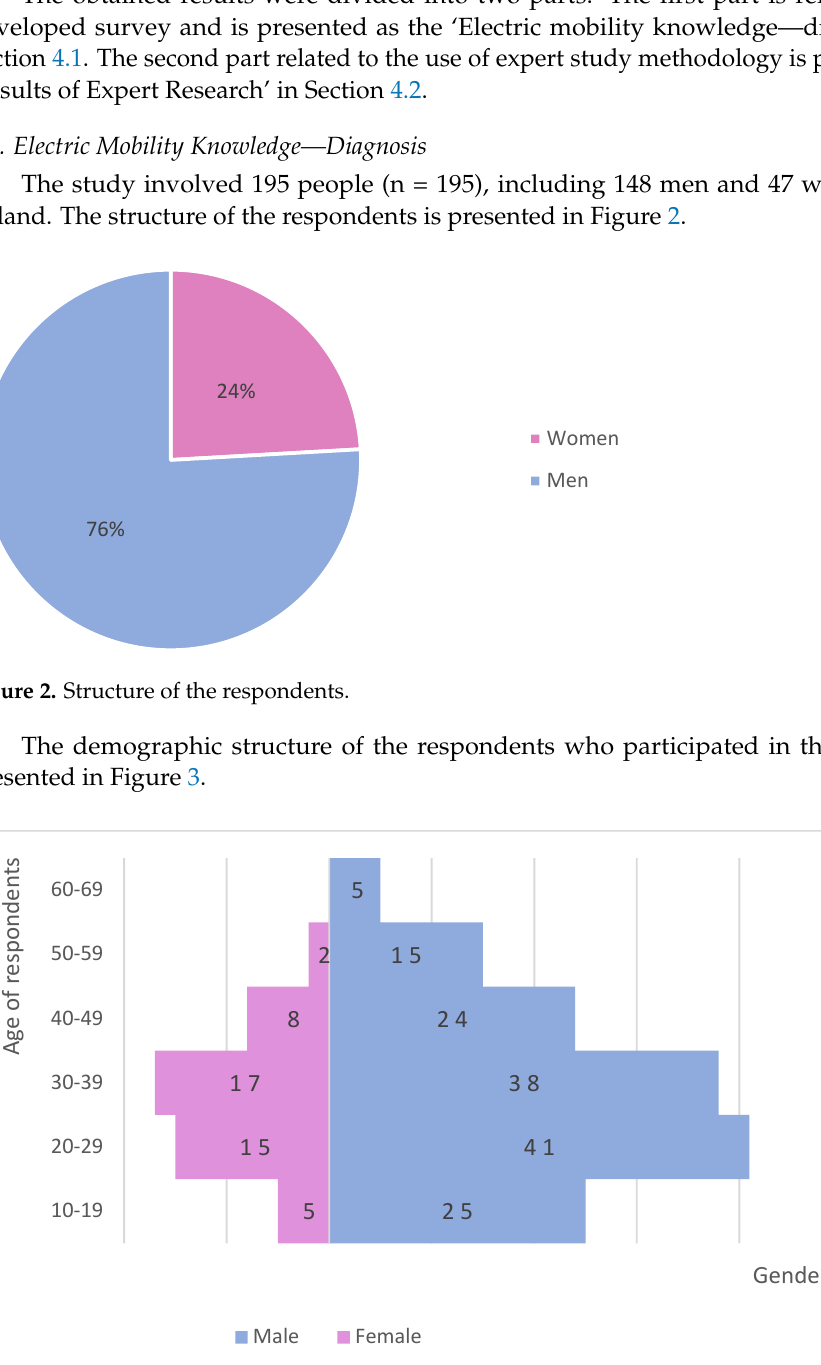
Figure 4. Structure of the level of education of the respondent. In the case of questions regarding the preferred form of electric mobility, the most preferred services were e-bike sharing (27% of the respondents), followed by e-car sharing (25% of the respondents) and e-scooter sharing (22% of the respondents). The least popu- lar were electric car ownership (14% of the respondents) and e-moped-sharing services (12% of the respondents). The heterogeneous distribution of the responses for this study was correct, as it was able to obtain answers to educational barriers and concerns about electric mobility from representatives of all forms of electric mobility. Detailed data are presented in Figure 5.